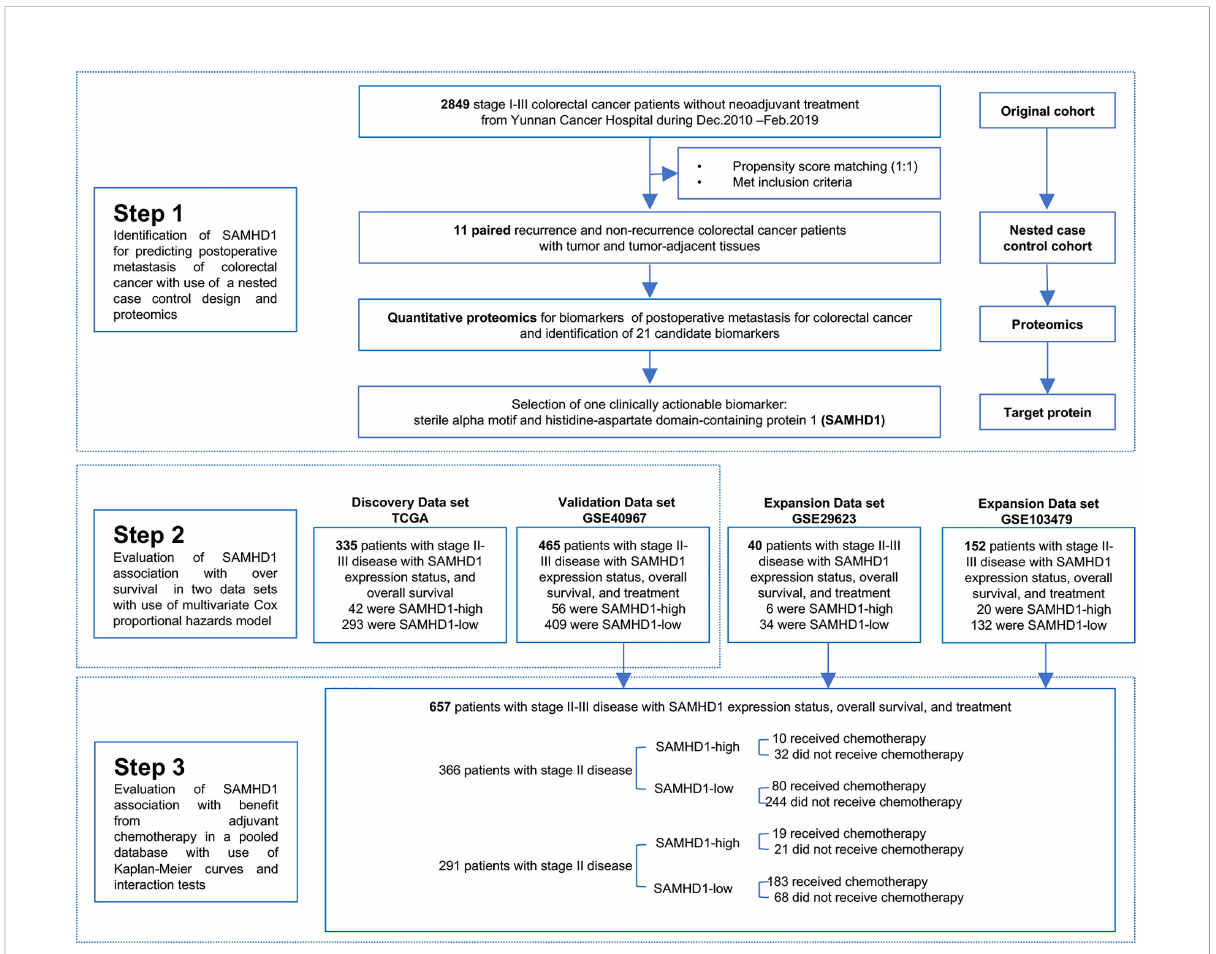
FIGURE 1 Study Design. PSM, propensity score matching; SAMHD1, sterile a motif and histidine-aspartate domain-containing protein 1; TCGA, The Cancer Genome Atlas; GEO, Gene Expression